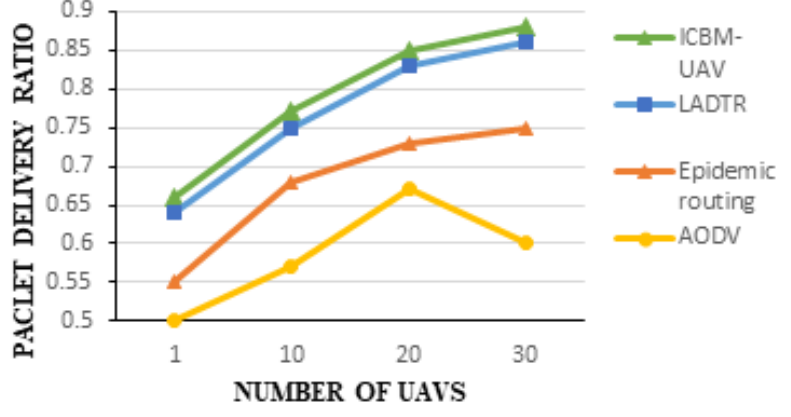
Figure 13. Packet delivery ratio with obstacles.